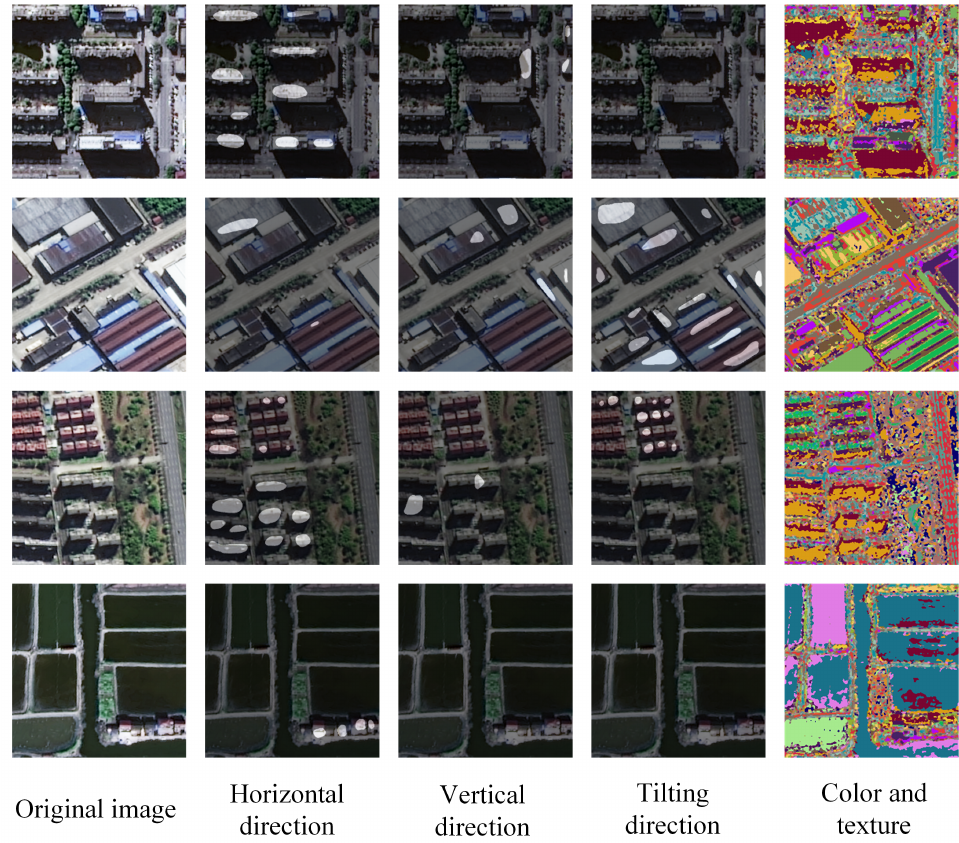
Figure 13. Visualization of posture and texture